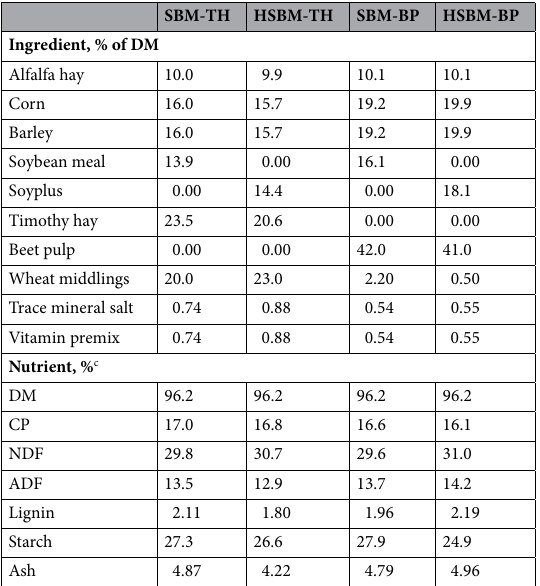
Table 1. Ingredients and nutrient inclusion for each treatment diet a,b . a HSBM-TH heat-treated soybean meal and timothy hay, SBM-TH soybean meal and timothy hay, HSBM-BP heat-treated soybean meal and beet pulp, SBM-BP heat-treated soybean meal and beet pulp. b Alfalfa hay, corn, barley, wheat middlings, trace mineral salt, and vitamin premix were incorporated into pellets along with either soybean meal or Soyplus to create the SBM and HSBM treatments, respectively. c Nutrient percentages are expressed on a DM basis except for DM, which is expressed on an AF basis.